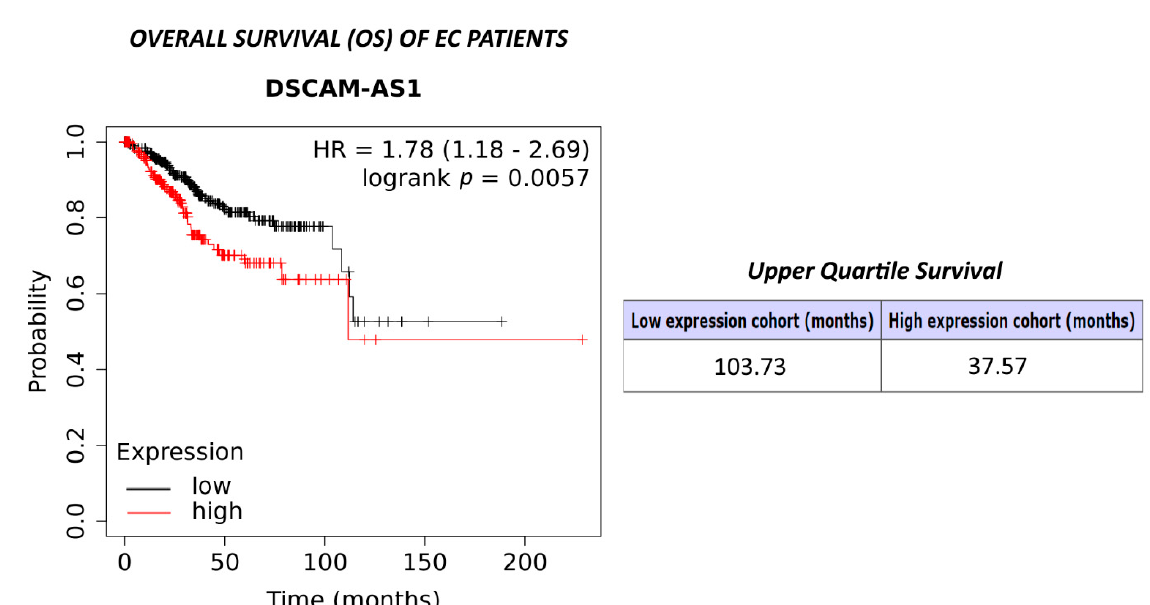
Figure 6. Kaplan-Meier plot showing the overall survival (OS) of 543 women with endometrial adenocarcinoma (EC) with high or low levels of DSCAM-AS1. The analysis was carried out using the data and software available at http://kmplot.com/analysis/index [28].